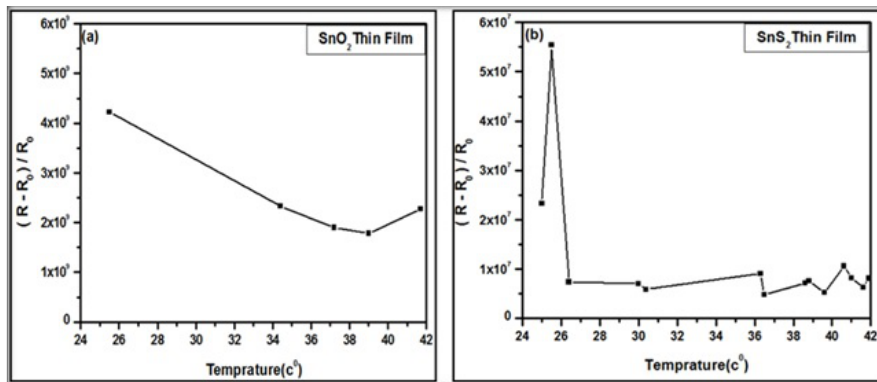
thin film and b) SnS thin 2 2